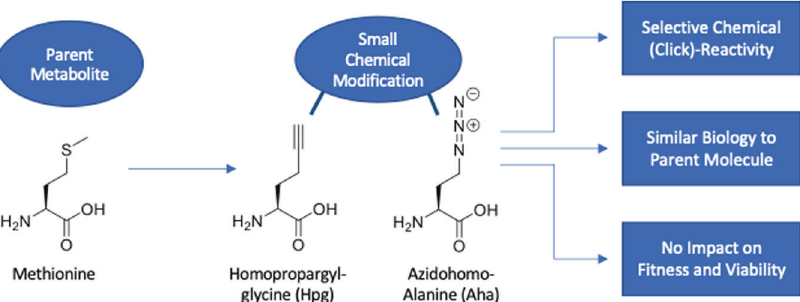
Fig. 1 Overview of the metabolic labeling approach: a parent molecule (in this case methionine) is chemically altered in such a way that a selectively reactive chemical group is introduced whilst only minimally altering the biological function. In case of methionine (1), its reactive analogues Hpg (2) and Aha (3) are still transported into cells and incorporated by the tRNA/synthase pairs into nascent